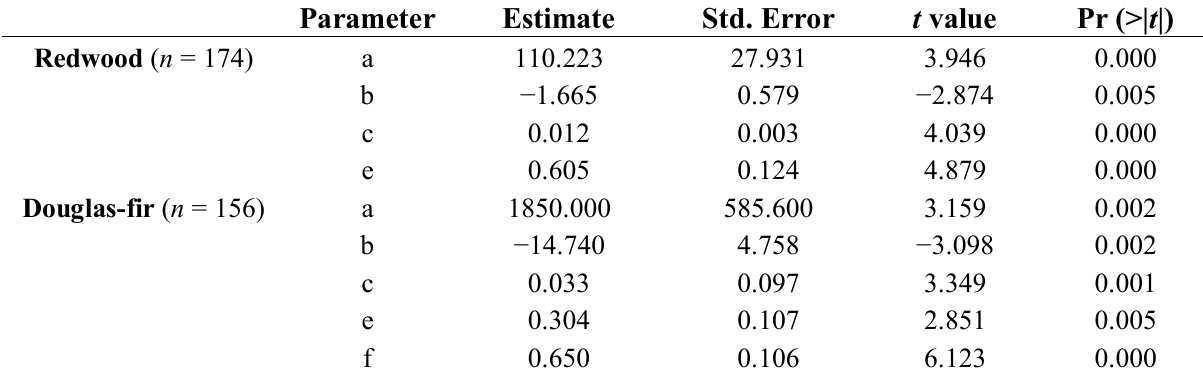
Table 5. Inverse polynomial diameter increment model coefficients and fit statistics for redwood and Douglas-fir trees sampled for growth at Headwaters Forest Reserve, California.